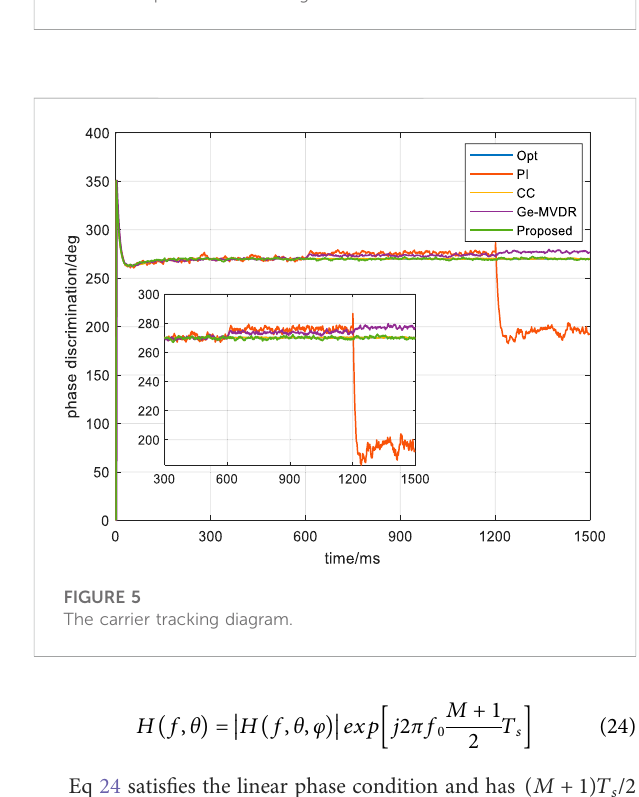
FIGURE 4 The null depth of three strategies at different INRs.